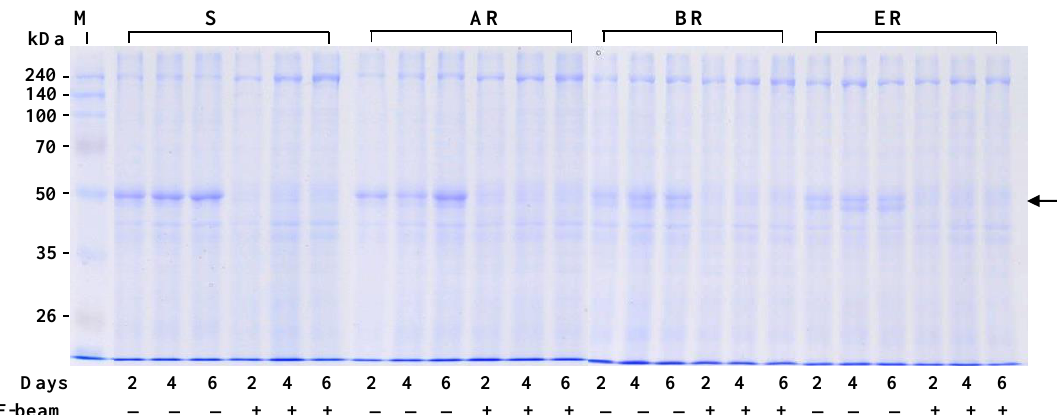
Figure 1. Changes in the expression of T. urticae proteins induced by electron beam irradiation. Protein was harvested from the S, AR, BR, and ER strains at 2, 4, and 6 days after electron beam irradiation (400 Gy) and analyzed by 10% SDS-PAGE. M, protein size marker; S, susceptible strain; AR, acequinocyl-resistant strain; BR, bifenazate-resistant strain; ER, etoxazole-resistant strain.